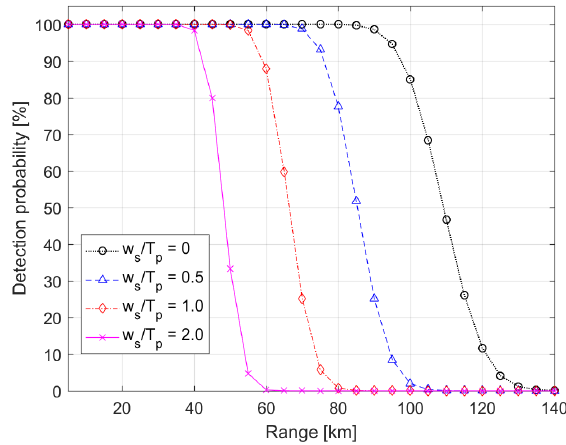
T ns. Figure 10. Detection probability for the fixed pulse width of T p = 8 p